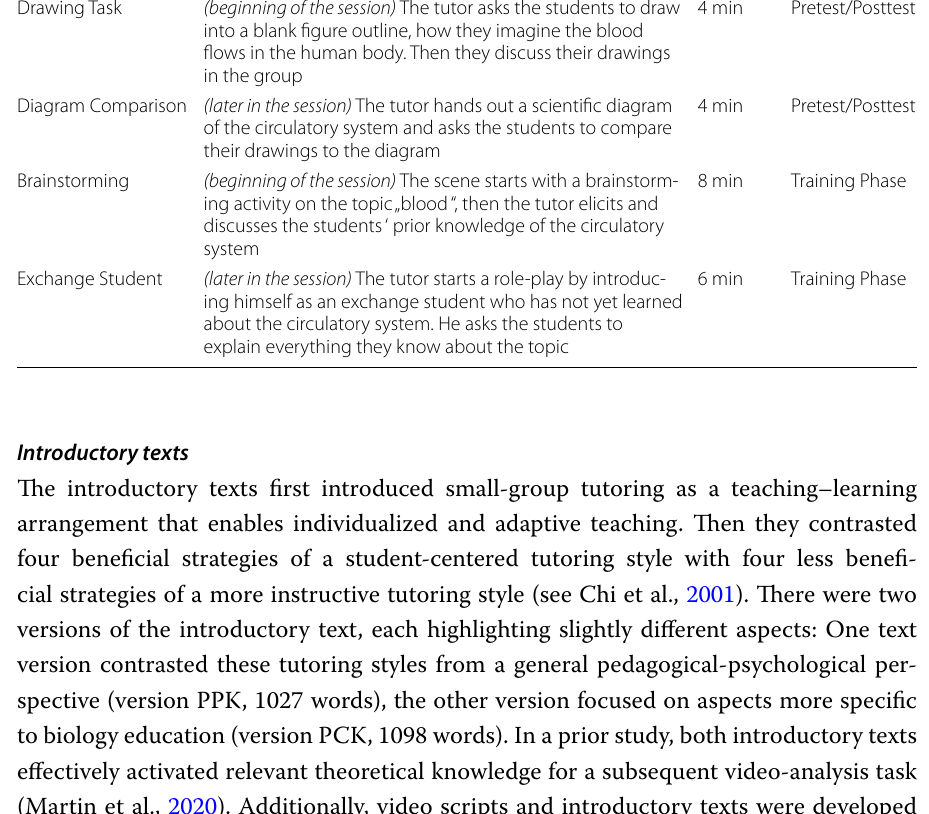
Table 1 Contents of the video examples used for pretest, training phase, and posttest Video title Description of the scene Duration Used for Drawing